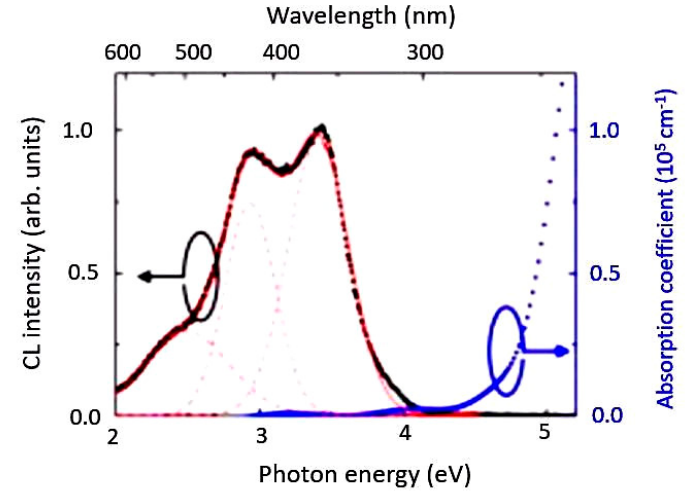
Figure 21. Cathodoluminescence (CL) and absorption spectra of the ZnGa 2 O 4 film. The CL spectrum is deconvoluted with three Gaussian curves centered at 2.5 eV (495 nm), 2.9 eV (428 nm), and 3.4 eV (365 nm) (dashed lines). The experimental data ( ■ ) is superimposed by the best-fit curve (solid line) [83] (with copyright permission from Elsevier, 2020).